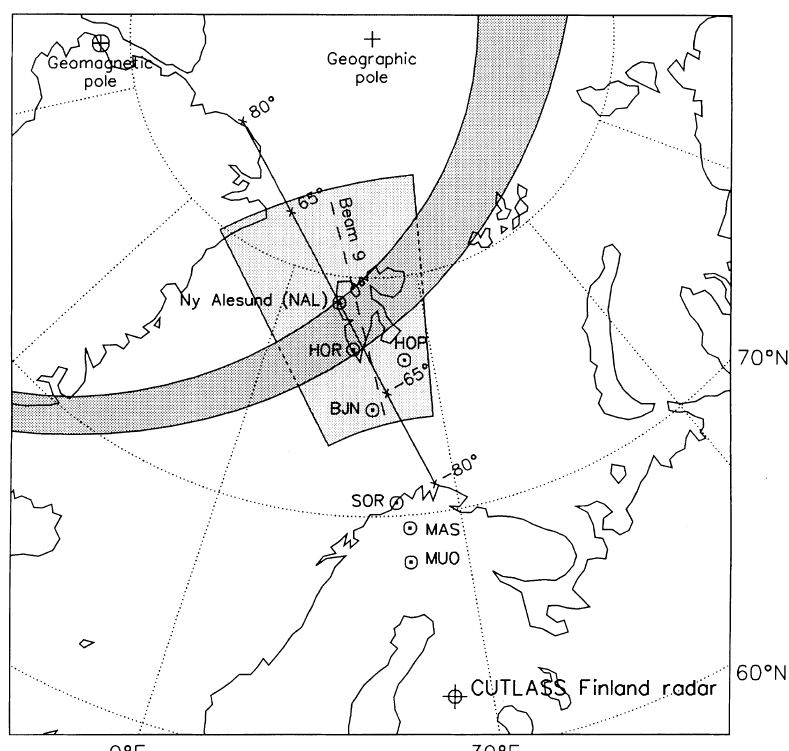
Fig. 1. The locations of the field-of-view of the CUTLASS Finland radar (beam 9 is explicitly in- dicated) and the meridian of the Ny A˚ lesund MSP, projected to 250 km altitude. Numbers to the right of the MSP meridian indicate the location of the projection of zenith angles 0 (cid:176) , 65 (cid:176) and 80 (cid:176) . The locations of the IMAGE magne- tometer sites at NAL, HOR, HOP, BJN, SOR, MAS, and MUO are indicated. Also illustrated for reference is the statistical location of the quiet ( K = 1) auroral oval at 0930 p